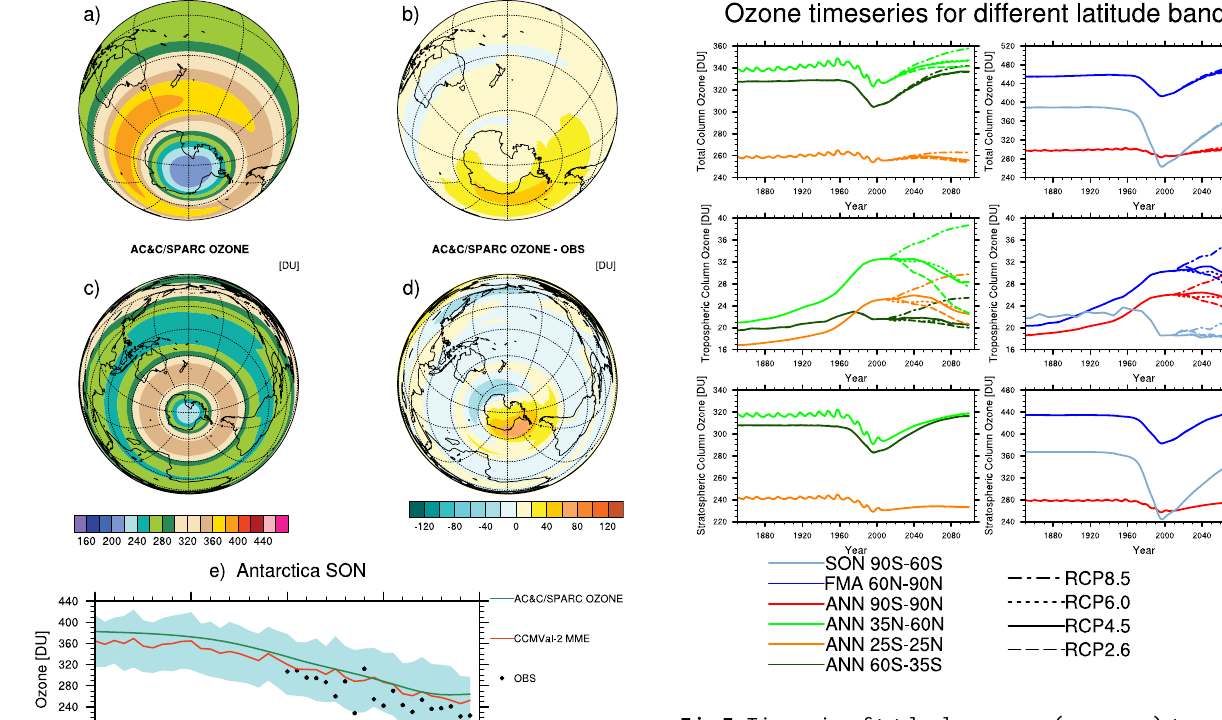
Fig. 7. Timeseries of total column ozone (upper row), tropospheric column ozone (middle row) and stratospheric column ozone (lower row) averaged over different latitude bands: Arctic (60–90 ◦ N), Antarctic (60–90 ◦ S), northern midaltitudes (35–60 ◦ S), southern midlatitudes (35–60 ◦ N), tropics (25 ◦ N–25 ◦ S), and global mean (90 ◦ N–90 ◦ S). The four future scenarios are RCP 2.6 (dashed lines), RCP 4.5 (solid lines), RCP 6.0 (dotted lines), and RCP 8.5 (dashed-dotted